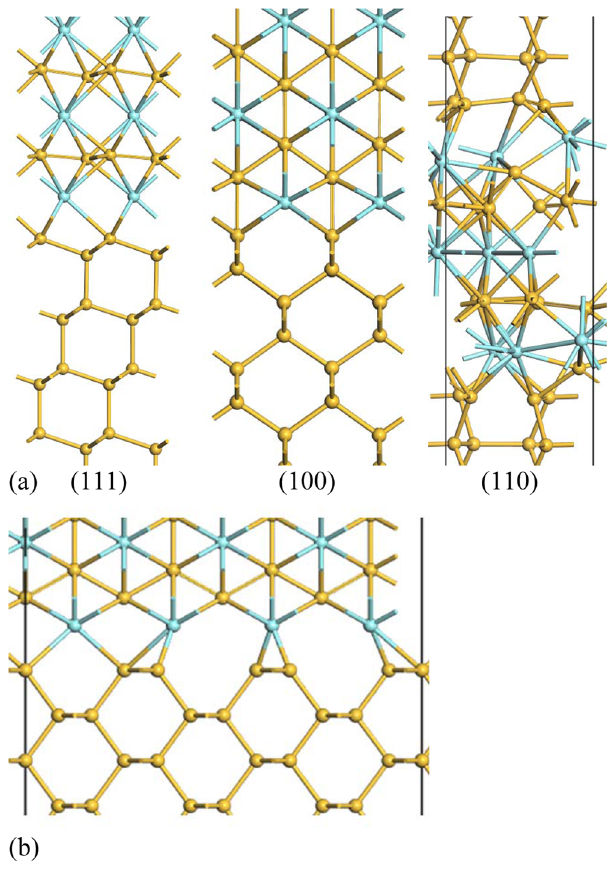
Figure 2. ( a ) Atomic structure of (111), (100), and (110) Si/YSi 2 interfaces; the (110) Si/YSi 2 interface with a disordered YSi